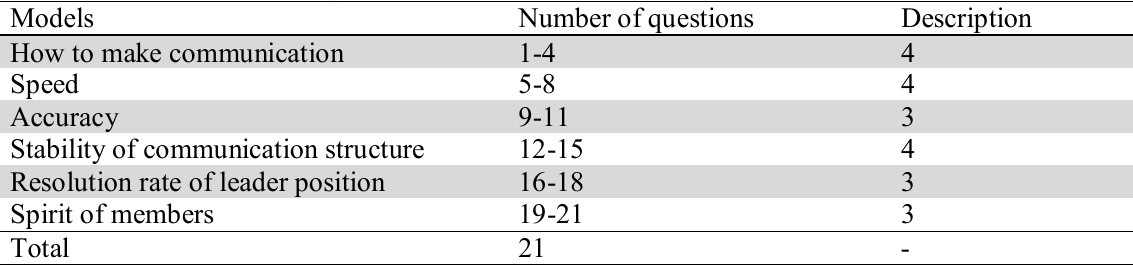
Communication model’s